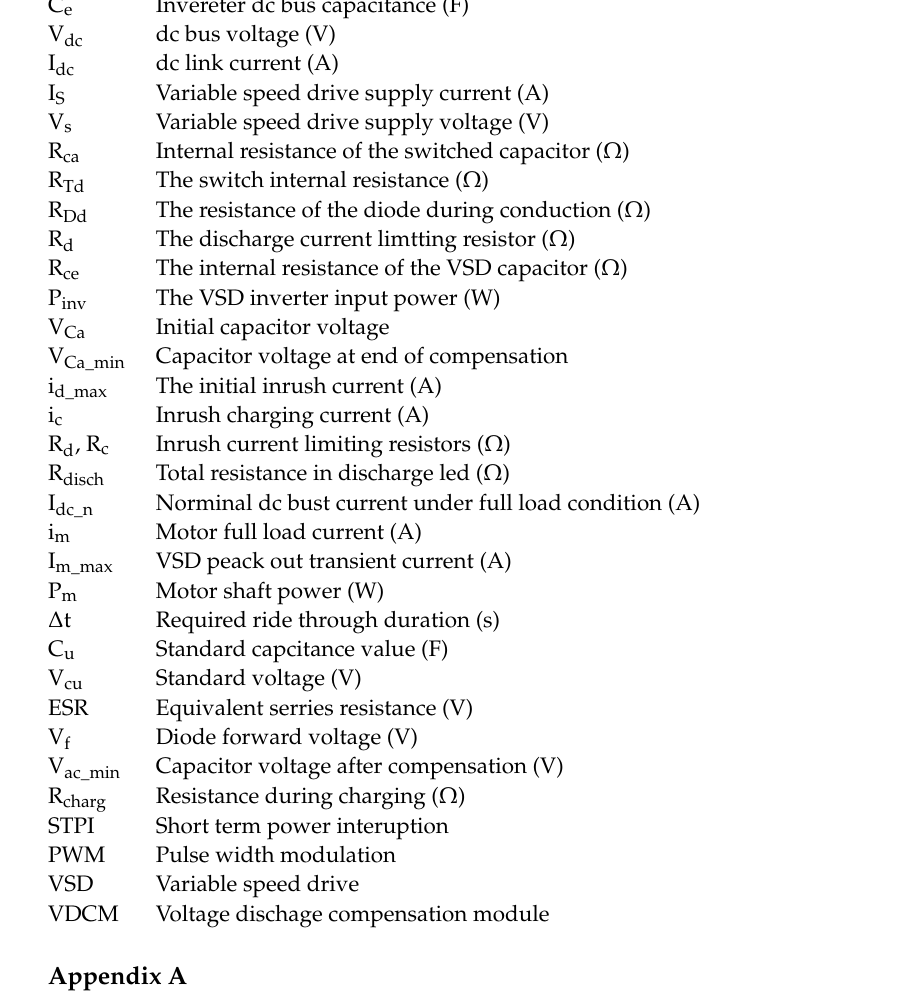
Table A1. The 1.5 kW induction motor parameters.